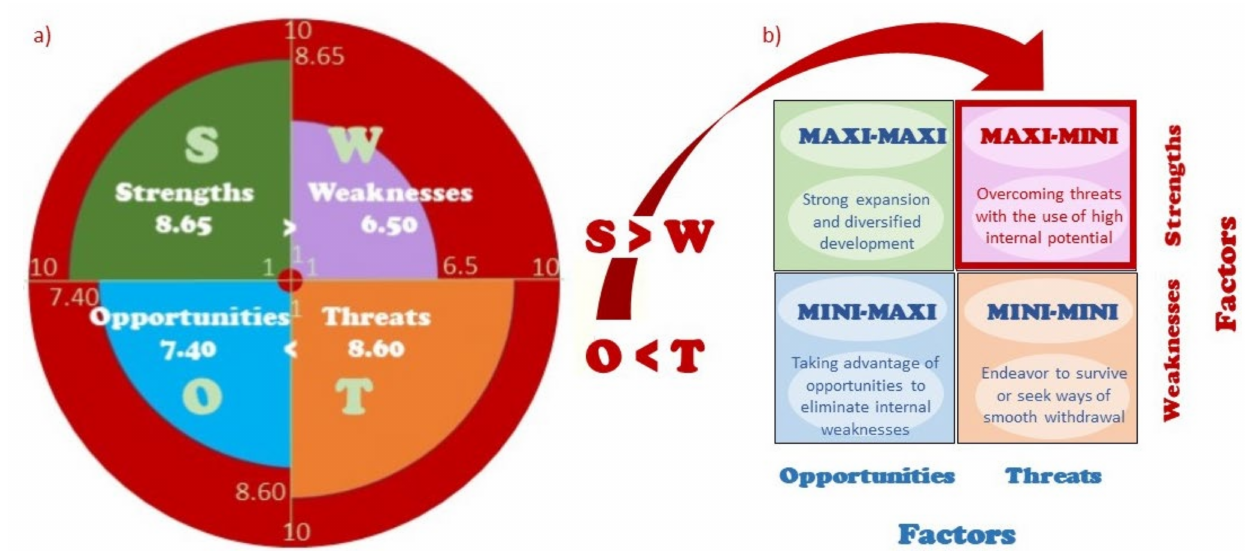
Figure 29. Results of contextual analyzes ( a ) SWOT (strengths-weaknesses-opportunities-threats) analysis concerning resilon as a filling material with the numerical reflection of individual aspects of the assessment indicating the strengths and threats advantage (the field area corresponds to the numerical rating of each analysis factor); ( b ) a diagram of choosing the MAXI-MINI development strategy from among 4 possible concerning resilon as a filling material because S > W and O <